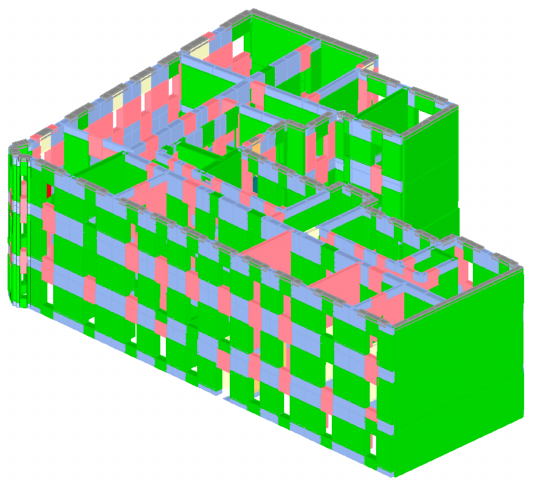
Figure 20. Damage at maximum displacement capacity for pushover in the y-direction.